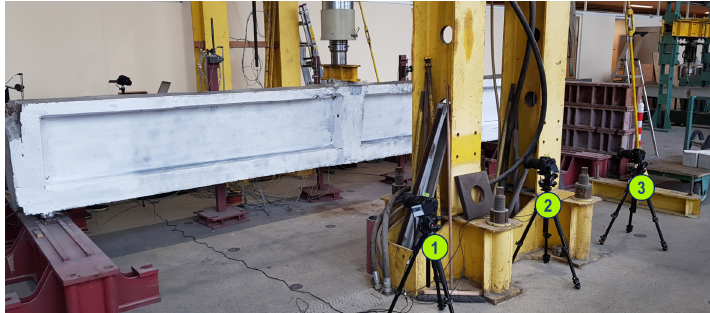
Figure 9. Test stand prepared for monitoring post-tensioned, precast crane runway beam during the three-point bending test using the CivEng Vision system.